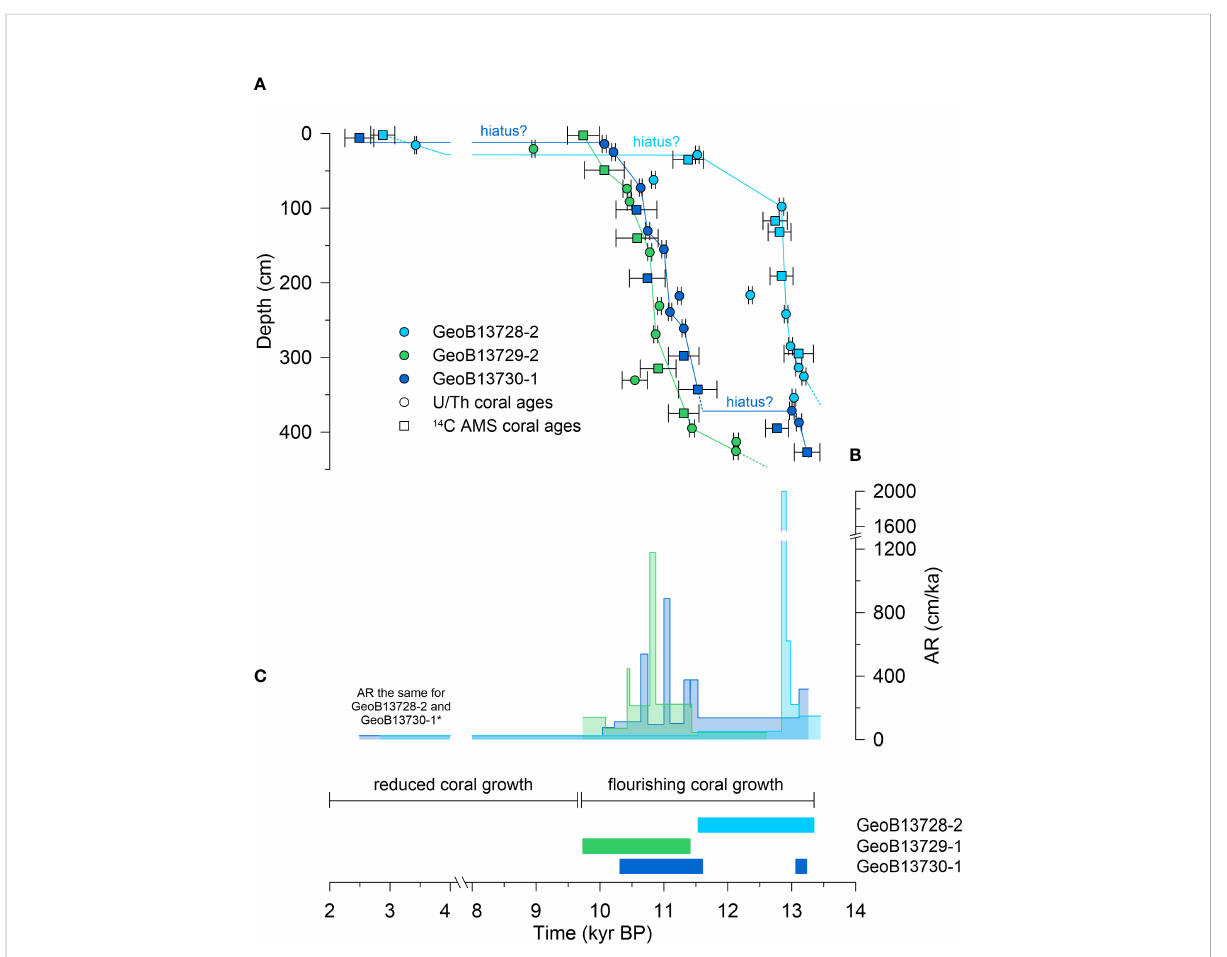
FIGURE 2 (A) Coral ages (in thousands of years before present) versus core depth. Dashed lines represent extrapolated values based on age models. Circles represent U/Th ages from this study and Wang et al. (2021). Squares represent AMS 14 C ages from Fink et al. (2013). (B) Coral mound aggradation rates (AR). Colors for cores correspond with those in (A, C) . (C) Intervals of fl ourishing coral growth interpreted from timings of rapid mound formation and coral framework in upright and/or slightly collapsed position (Supplementary Figure 1). Note that the x-axis breaks from 8 – 4 kyr BP. * see Section 3.1 for